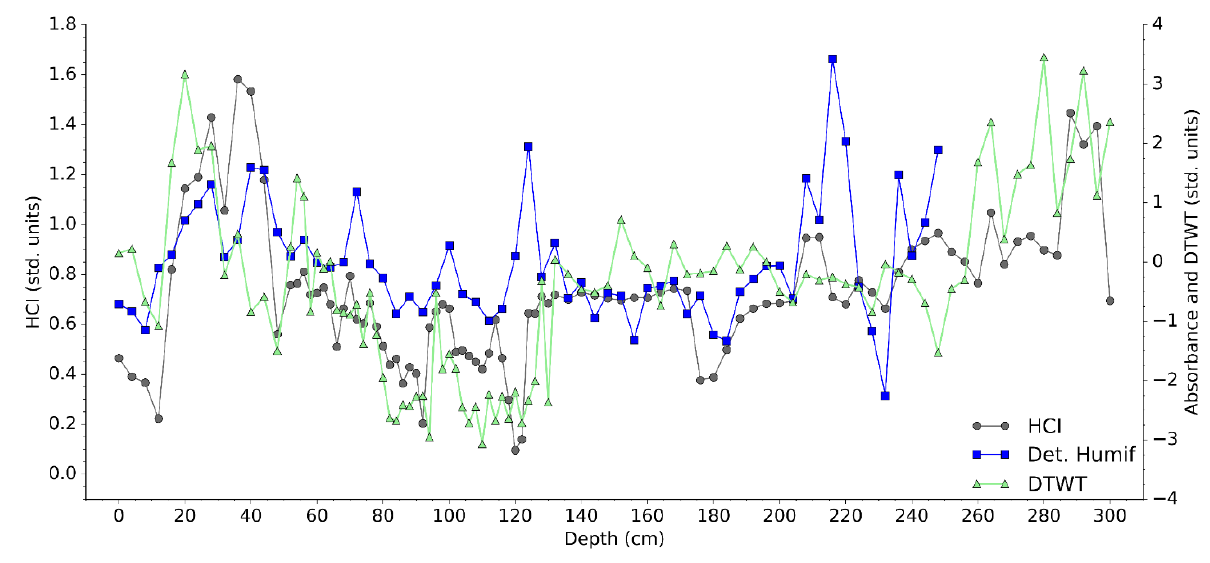
Figure 6. All proxies vs depth from Killorn Moss. Grey line and circles, blue line and squares and green line with triangles represent macrofossil HCI, humification absorbance and Depth To Water Table (DTWT) respectively. All are in standardised